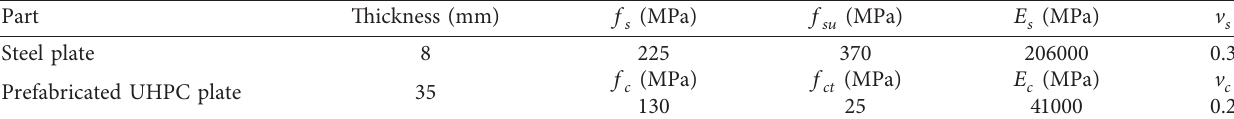
Table 4: Mechanical properties of steel plate and prefabricated UHPC